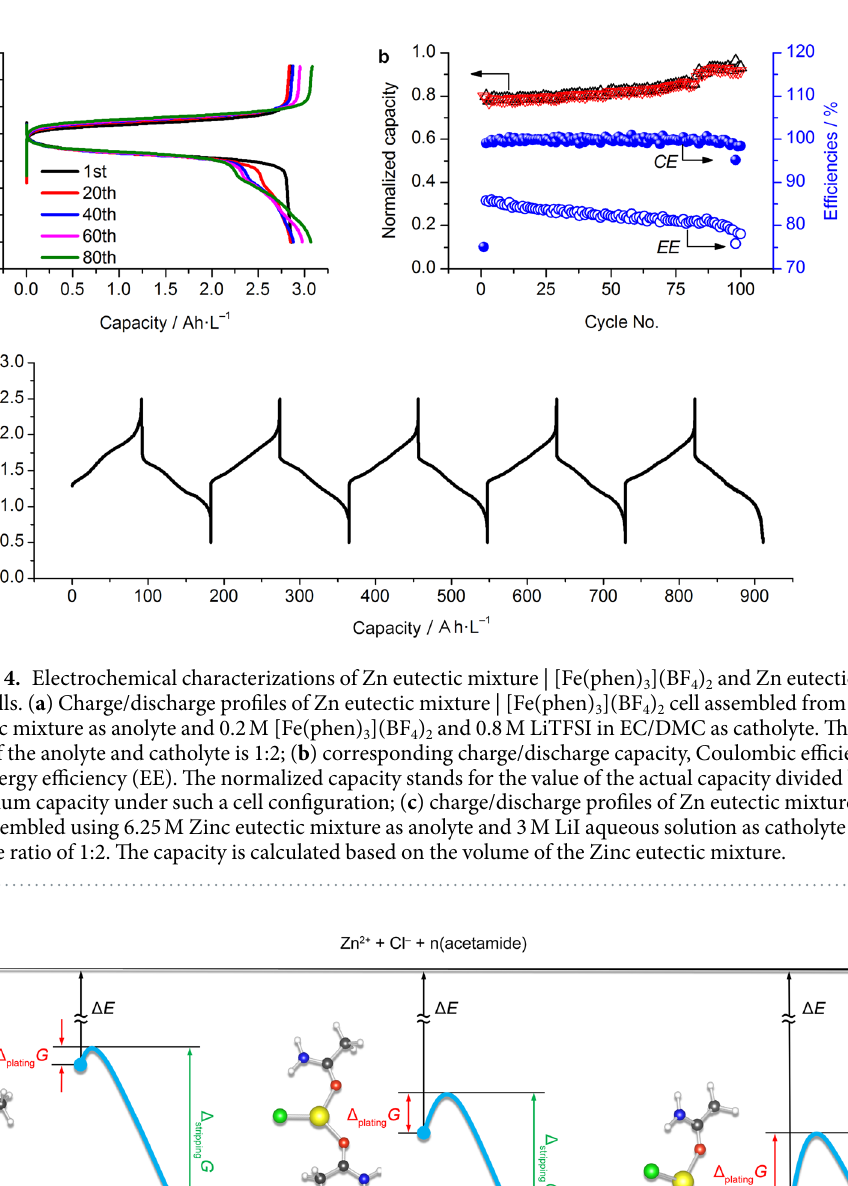
other two geometries. The Zn electroplating processes were supposed to composed of two dynamic equilibrium processes and one major path through reactions (1–3):